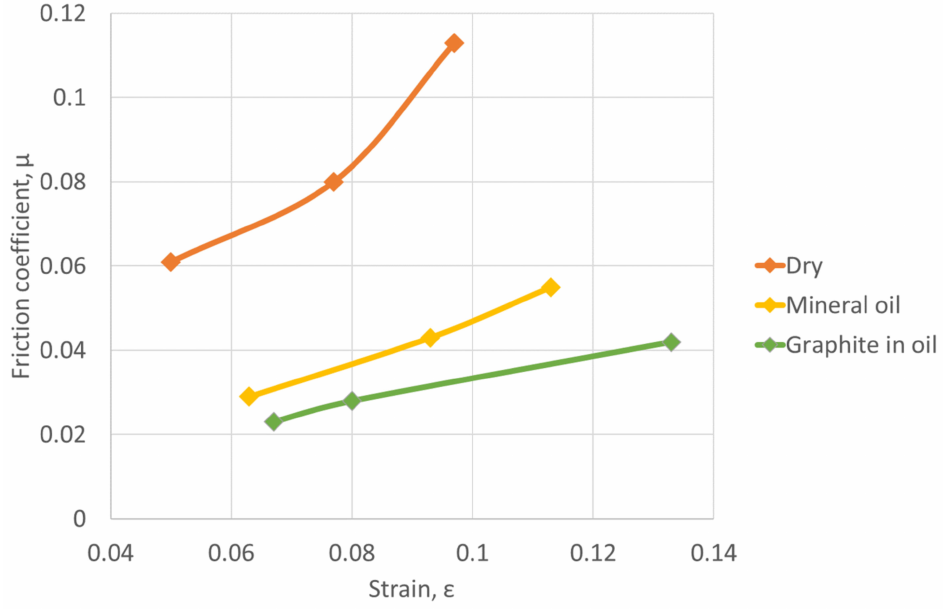
Figure 12. The variation of the friction coefficient vs.